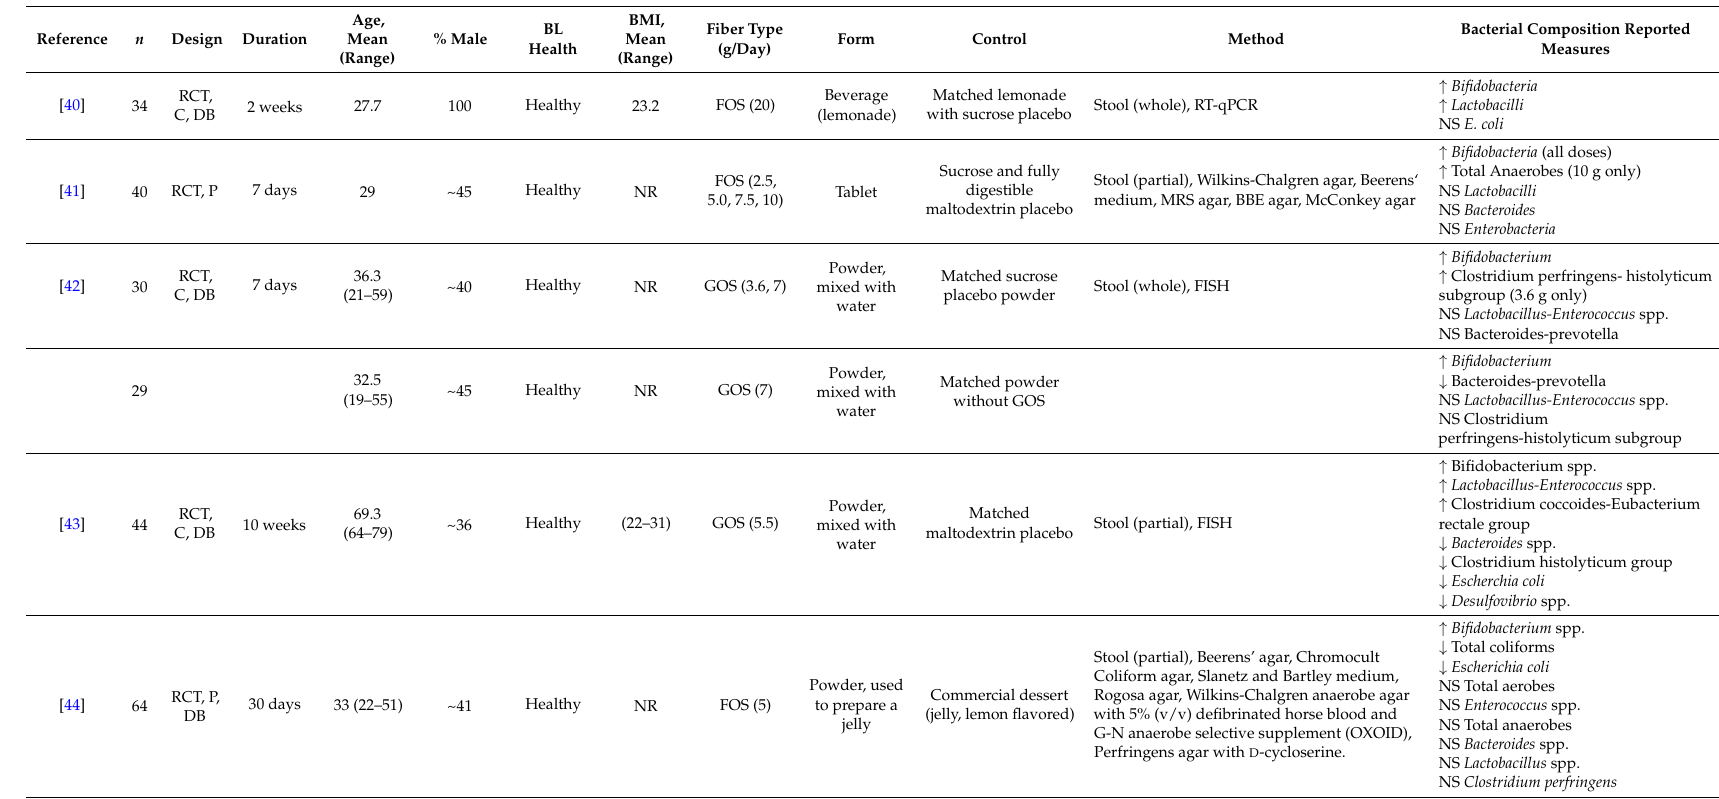
Commercial dessert (jelly, lemon